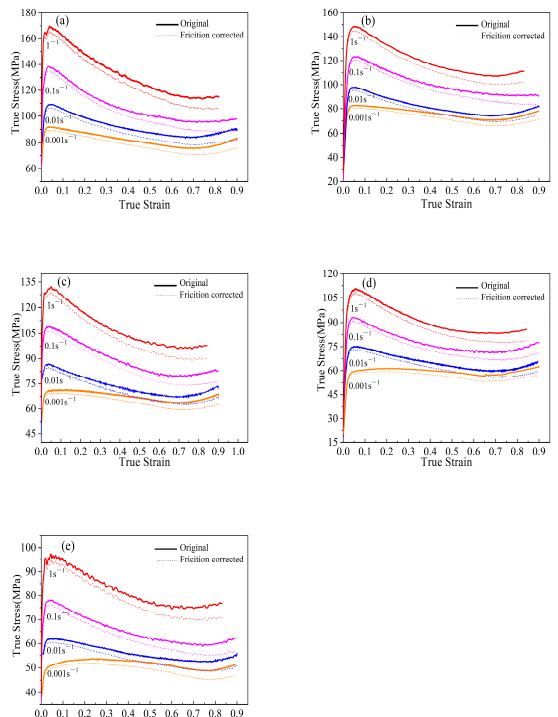
Figure 5. True stress–strain curves of B 4 C p /6063Al composite at the temperature of ( a ) 573 K, ( b ) 623 K, ( c ) 673 K, ( d ) 723 K, and ( e ) 773 K.